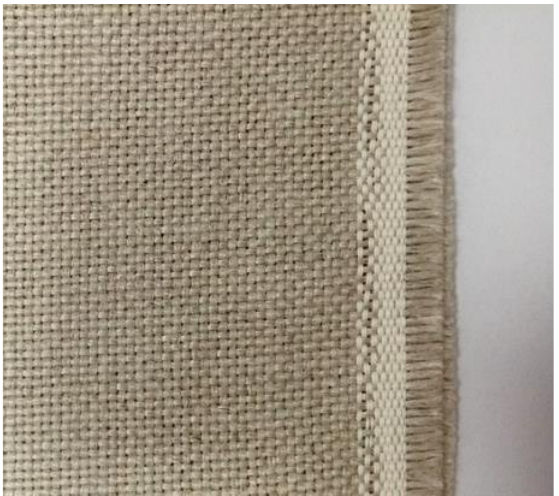
Figure 3. Flax fabric (own source).